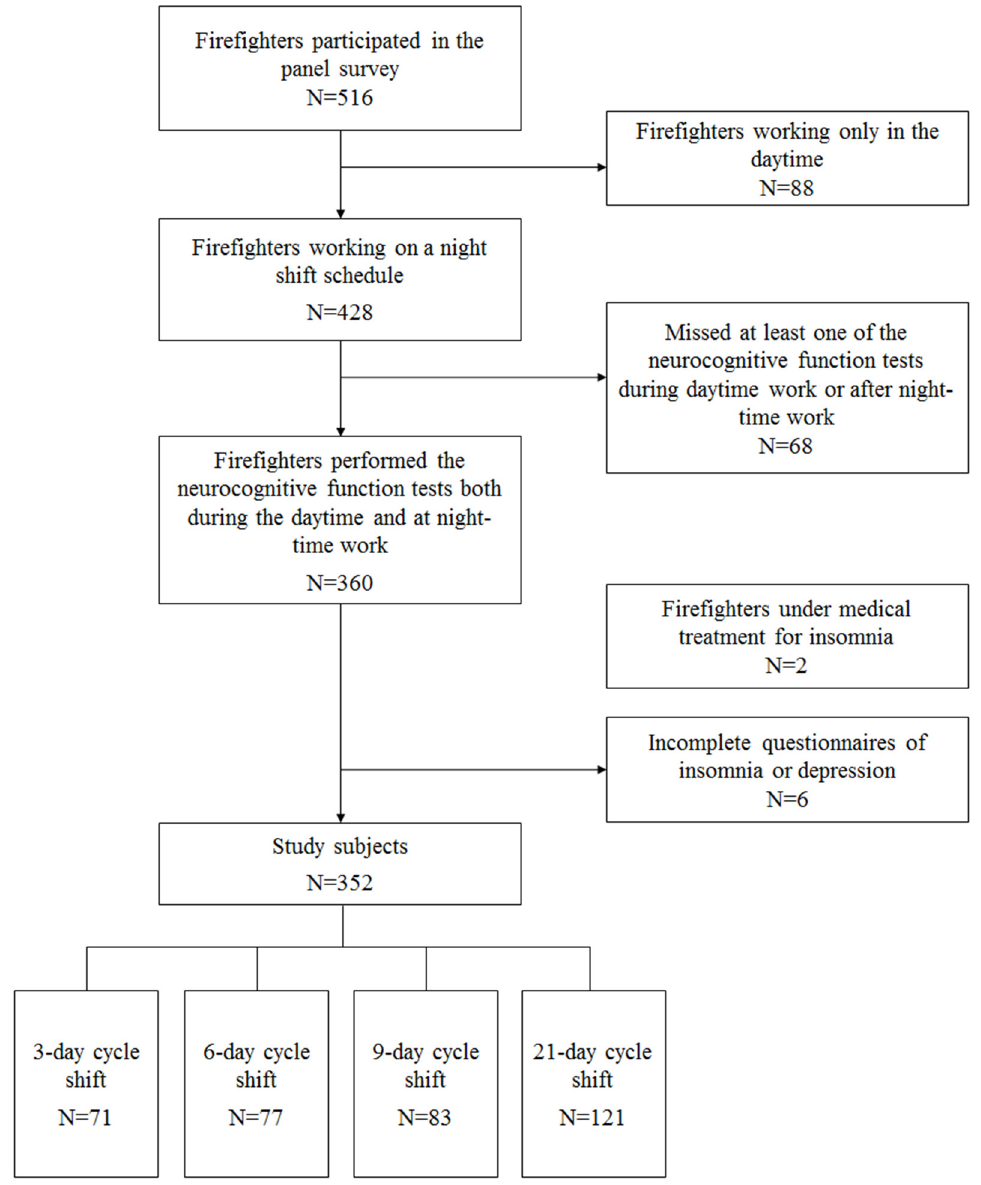
Figure 1. Flow chart of the study subjects .